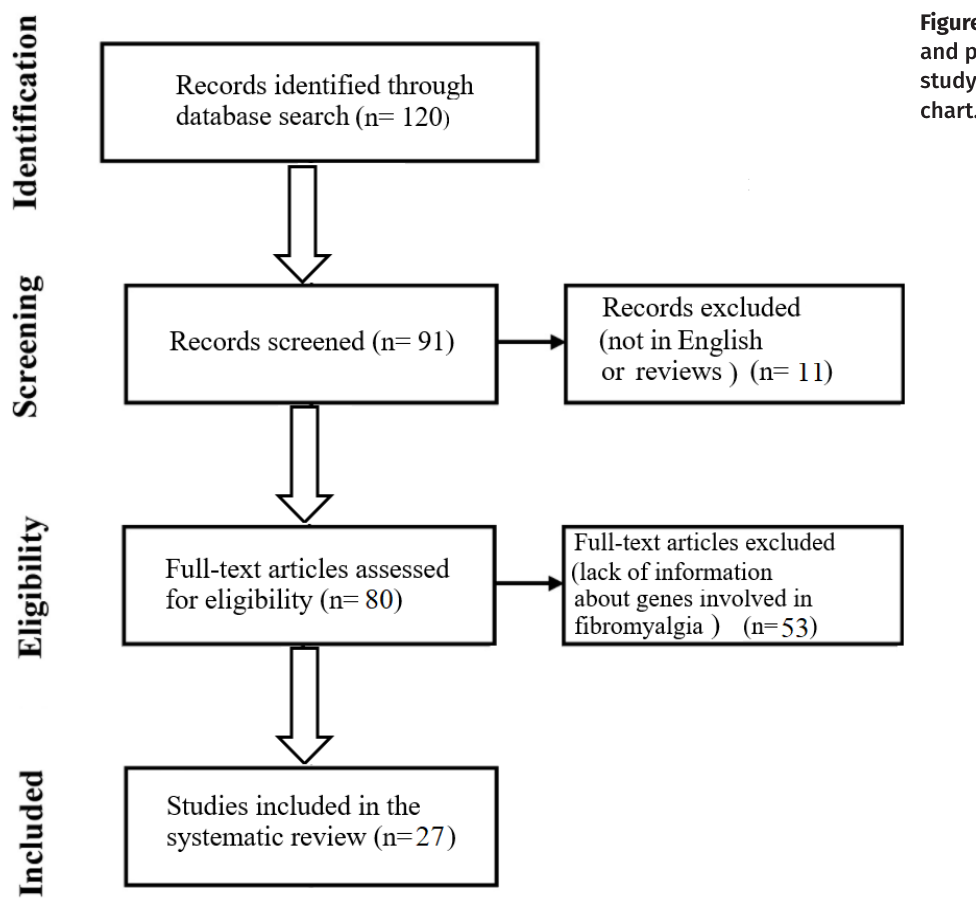
Figure 1. Fibromyalgia and polymorphisms: study selection flow